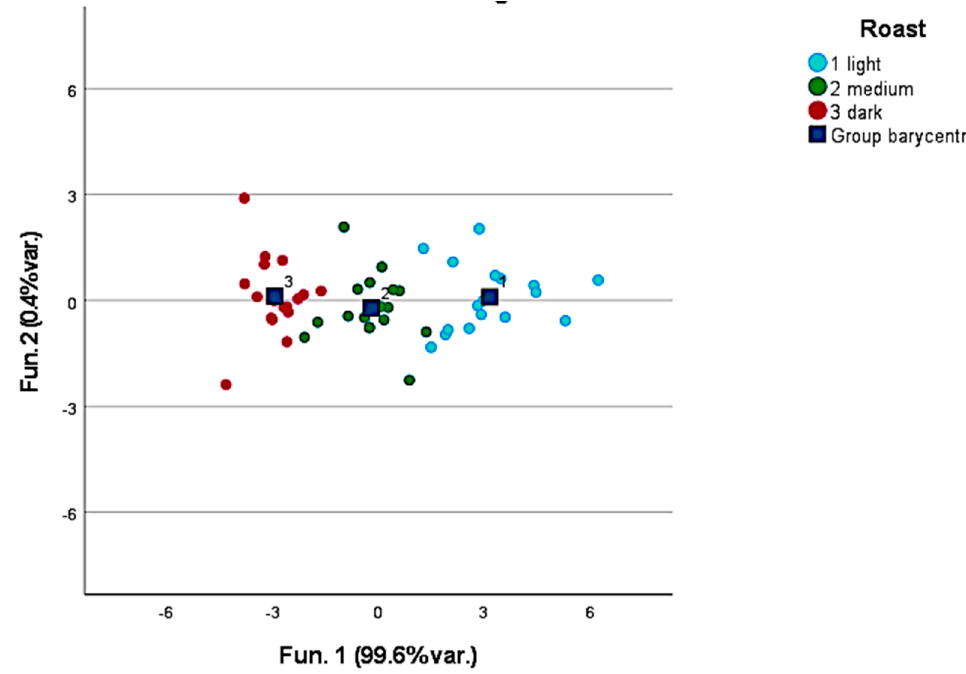
Figure 5. Discrimination of roasting levels in the African coffee subcluster.